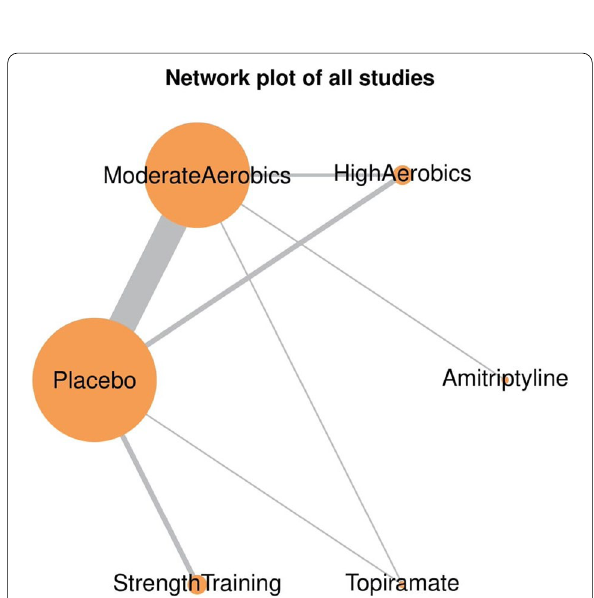
Fig. 2 Network plot of all studies included. The size of the nodes and the thickness of edges depend on the number of people randomized and the number of trials conducted,